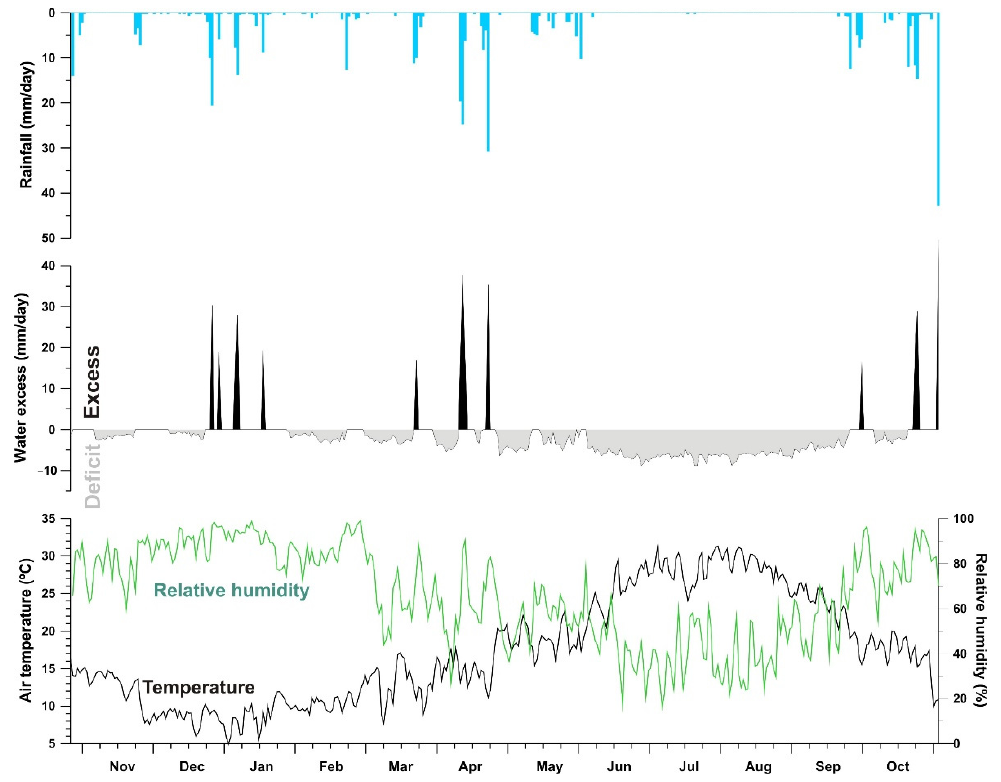
Figure 2. Local daily meteorological conditions during the monitoring period.